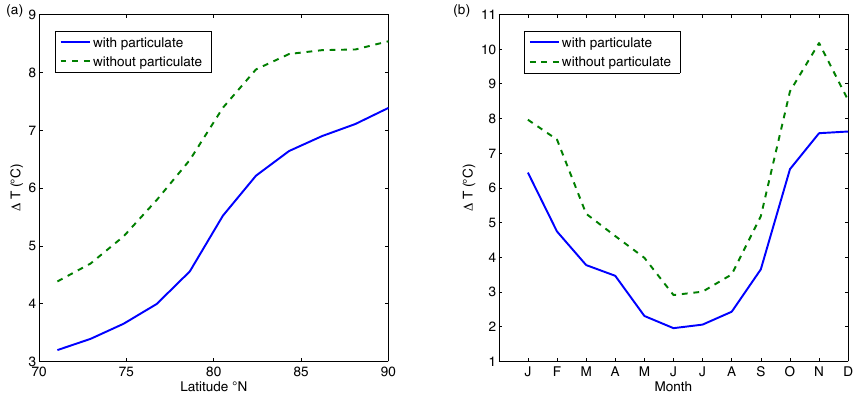
Fig. 17. Two meter air temperature change ( 1T ), in ◦ C, due to doubling CO 2 in pairs of integrations with and without particulate impurities in snow and sea ice as a function of latitude (a) and month (b) for latitudes North of 70 ◦ N.